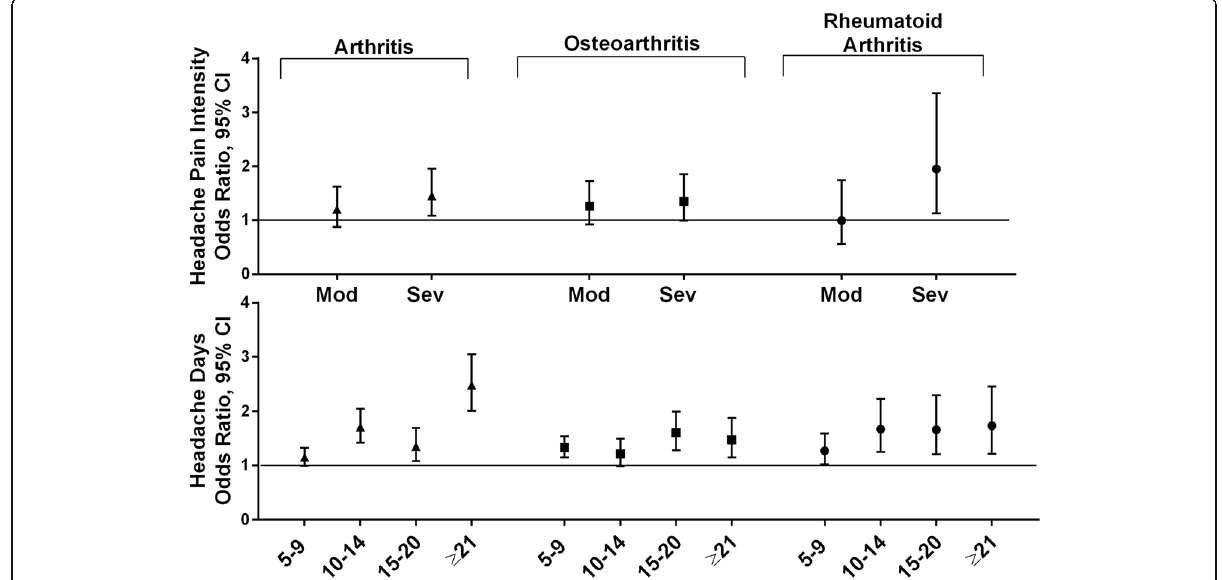
Fig. 7 Among persons with migraine the odds ratios (and 95% CI) for each comorbid pain condition*. *Fully adjusted models with sociodemographic characteristics (age, gender, Hispanic origin, race, marital status, employment, household income), headache pain intensity and headache frequency. Reference groups are low headache pain intensity for headache pain intensity and low frequency headache (1 – 4 MHDs)